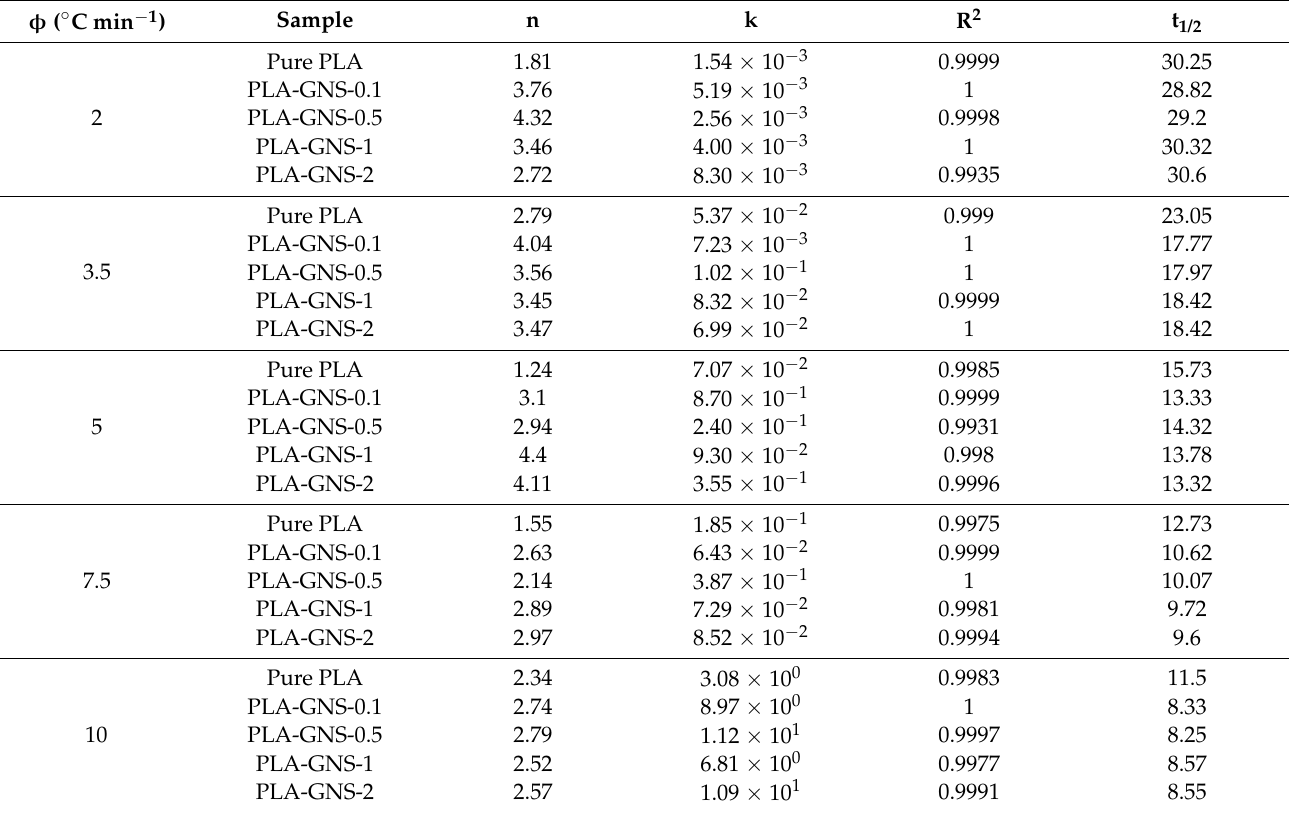
Table 3. Avrami parameters, n and k, of pure PLA and PLA-GNS nanocomposites at selected cooling